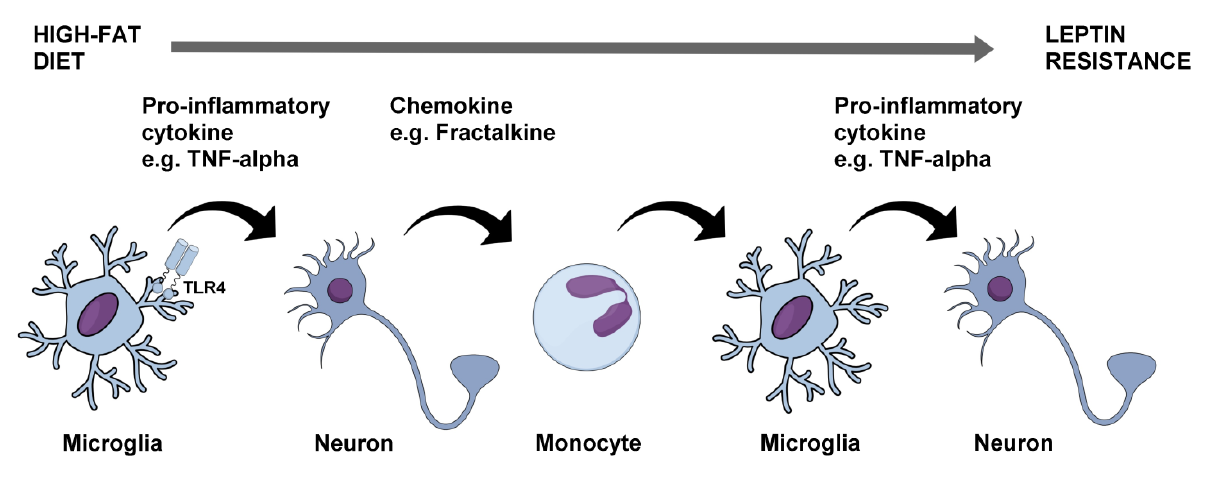
FIGURE 3: Molecular and cellular processes linking chronic high-fat diet consumption with leptin resistance and obesity. The rise in cir- culating saturated fatty acids from chronic consumption of a high-fat diet leads to activation of TLR4 in hypothalamic microglia which then release pro-inflammatory cytokines such as TNF-α. This in turn leads to the release of the chemokine fractalkine from adjacent neurons which recruits circulating monocytes into the hypothalamus and which then differentiate into activated microglia. A vicious cycle is thus initiated which progressively worsens leptin resistance in hypothalamic neurons contributing to increased food intake and obesity. TLR4 – toll-like receptor 4, TNF-alpha – tumor necrosis factor